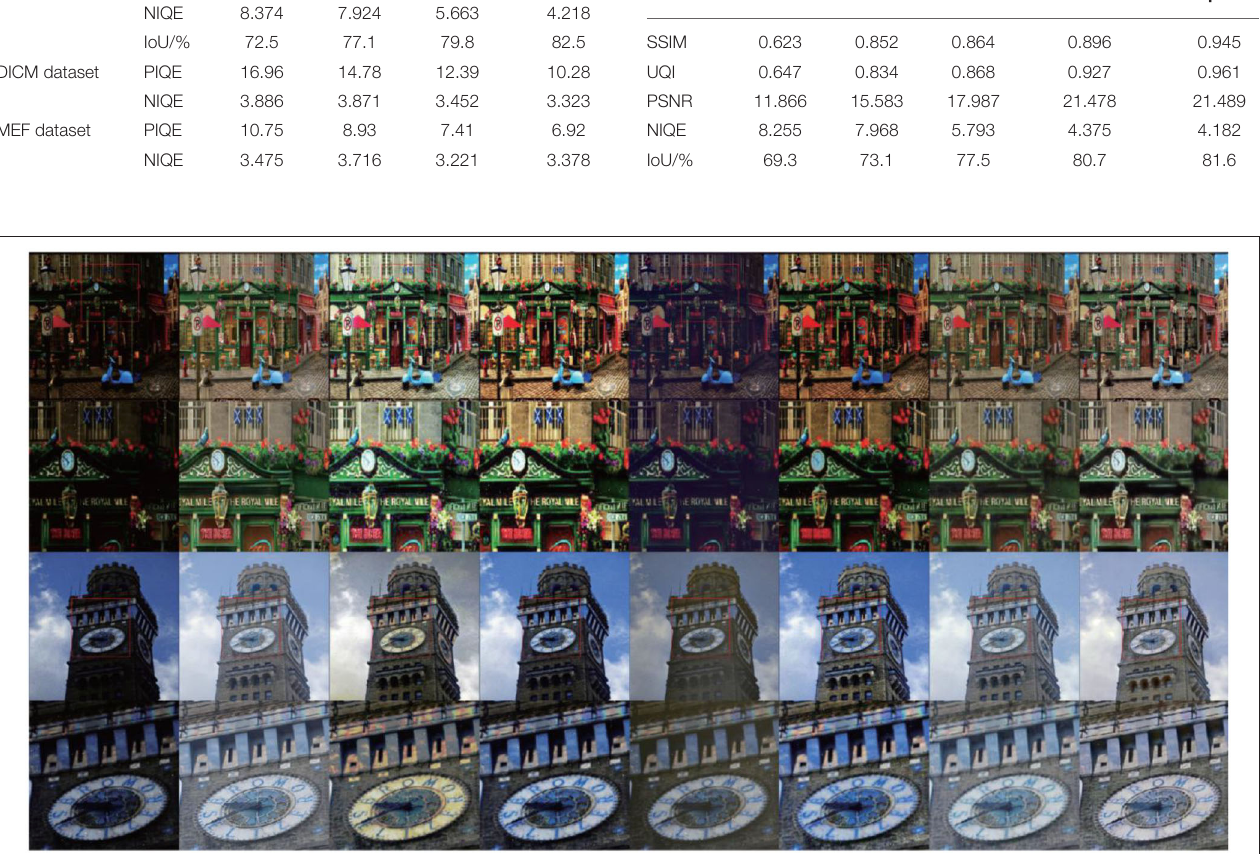
FIGURE 7 | Subjective visual comparison with different algorithms on synthetic low light images. From left to right: original image, ground truth, SEM method, VBSA method, APM method, RetinexDIP (Zhao et al., 2021), Proposed.